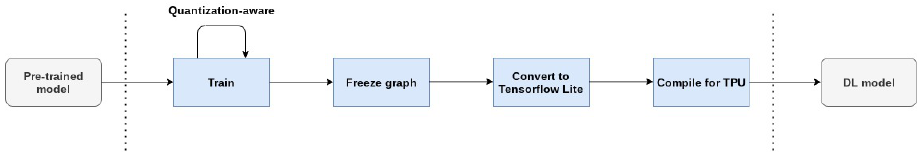
Figure 6. Steps to train and deploy a pretrained model into Google’s Coral USB Accelerator